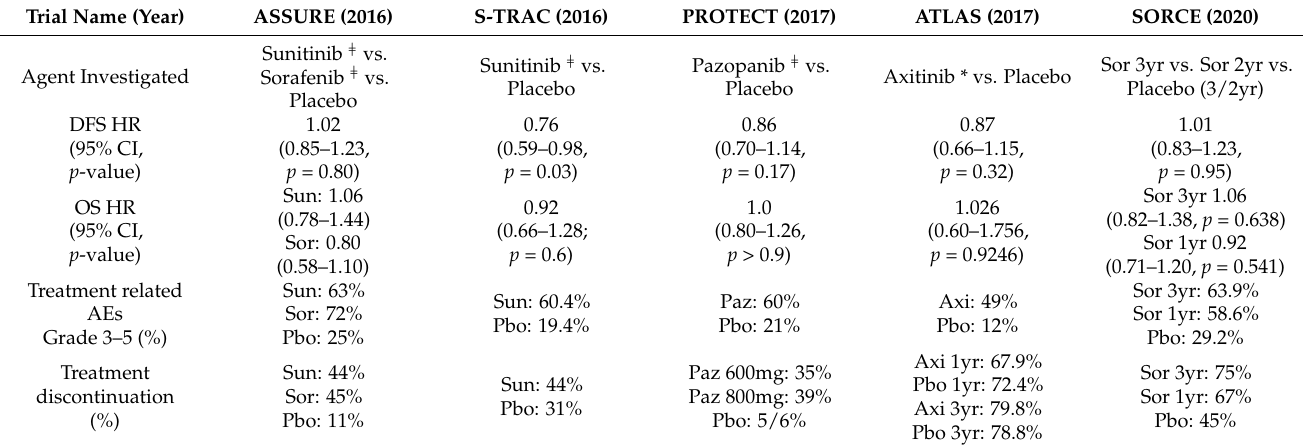
Table 1. Completed Adjuvant Phase 3 Trials with VEGFR TKIs in